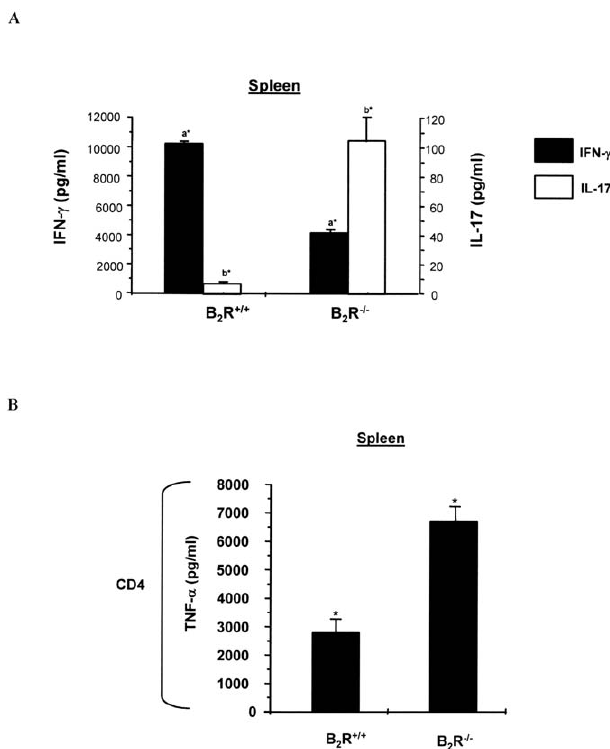
Figure 6. The Depressed T H 1 Response of B 2 R (cid:2) / (cid:2) -Infected Mice Is Inversely Correlated with Increased Production of IL-17 Splenic CD4 þ T cells, isolated from infected B 2 R þ / þ and B 2 R (cid:2) / (cid:2) mice (28 d p.i.). T cells were co-cultured with CD11c þ DCs pulsed with T. cruzi Ag (25 l g/ml) for 72 h at 37 8 C. Culture supernatants were harvested and assayed for IFN- c and IL-17 (A) and TNF- a (B) levels by ELISA. Values are the mean 6 SD from one representative experiment with individual cells from five mice/group. Statistics were done by ANOVA and pair-wise comparisons were done by the Tukey test (a*, p , 0.05; b*, p , 0.01; *, p ,